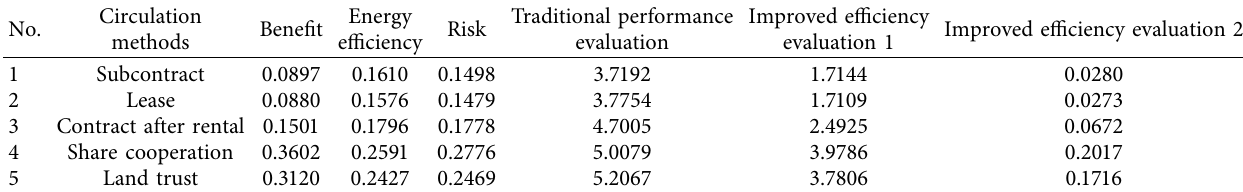
Table 7: The efficiency analysis list of the rural land circulation